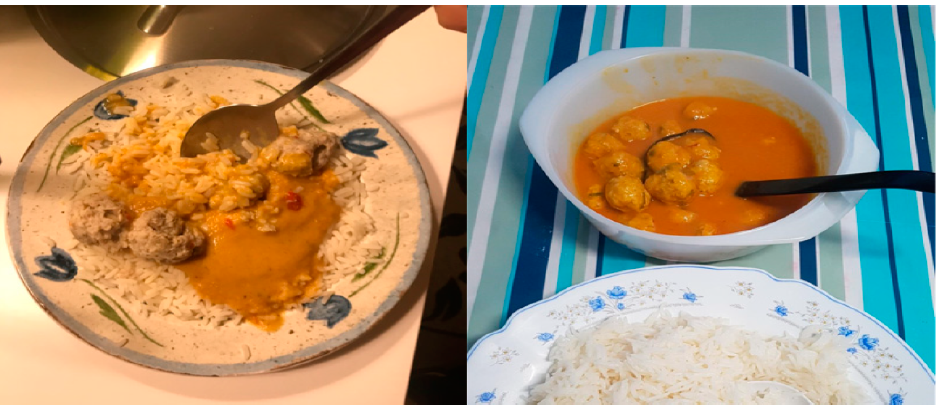
Figure 3. ‘Curry Nam-Nam’, a recipe with chicken meat balls in vegetable sauce, was cooked by several families at home, with parents and children cooking together (photos sent by two families during the cooking class